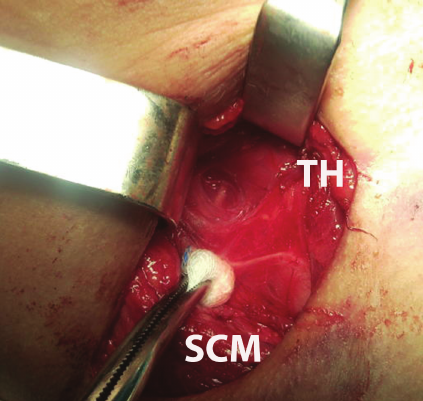
Figure 2: Intraoperative view with the foreign body in the center of the surgical field. The thyroid gland (TH) and the sternocleido- mastoid muscle (SCM) have been retracted. The recurrent laryngeal nerve crosses the surgical field.